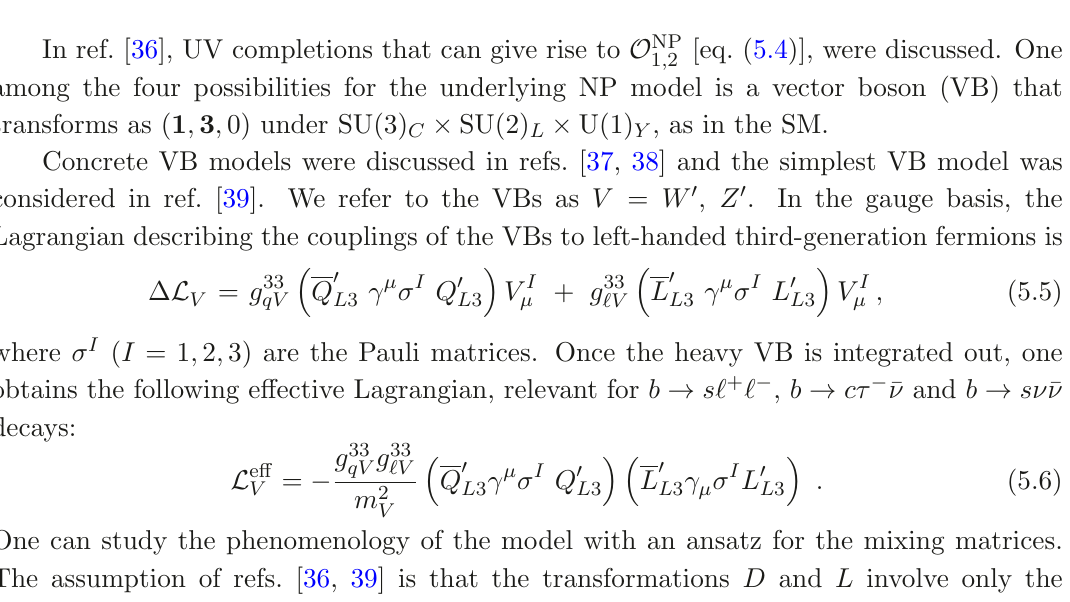
Table 5 . Quantum numbers of scalar and vector